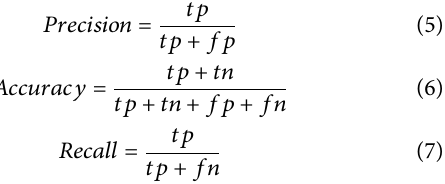
Frontiers in Chemistry |